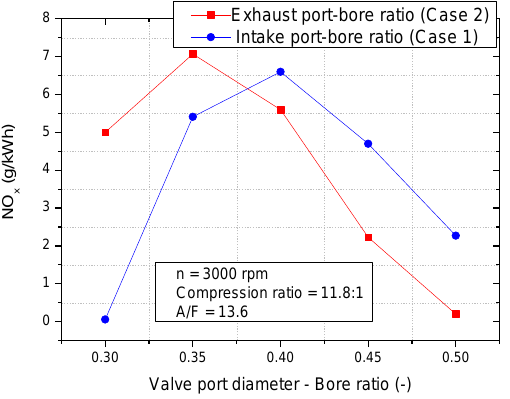
Figure 19. Brake torque versus VPD/B.